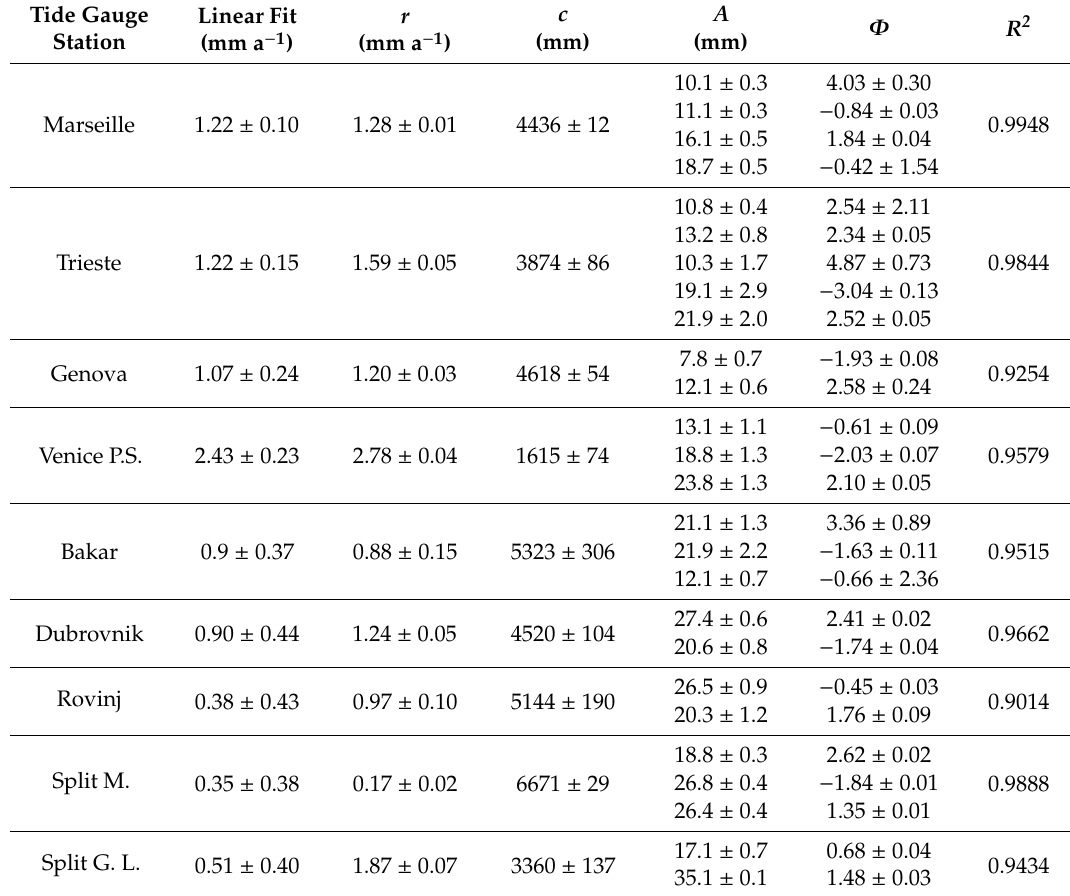
Table 2. Fit parameters and adjusted R-square values for the analyzed data set. Uncertainties define the 90% confidence